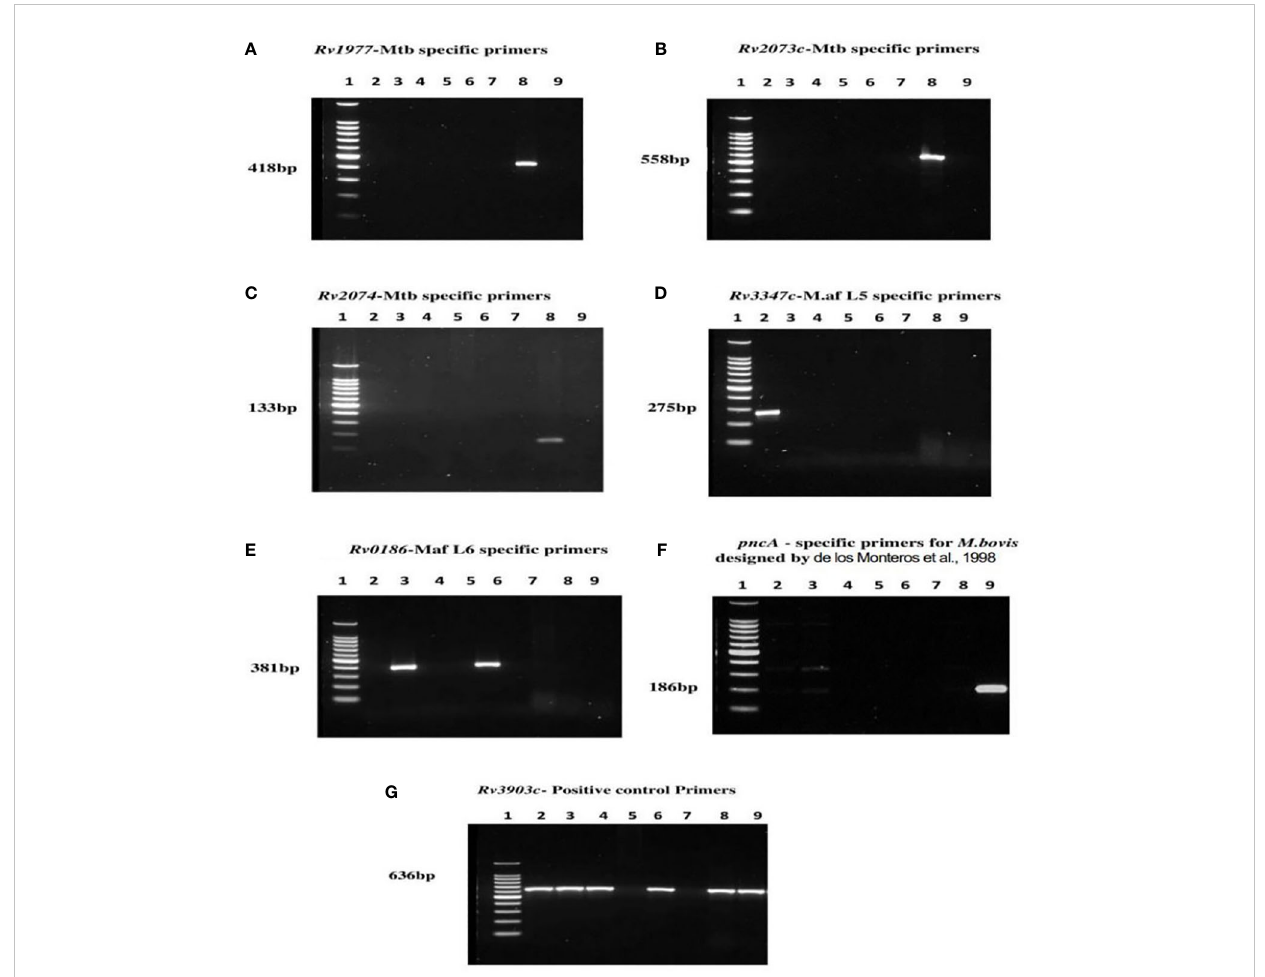
FIGURE 4 PCR results of MTBC speci fi c lineages after optimization of various product sizes; Lane 1= DNA ladder, 2= M. africanum L5, 3= M. africanum L6 (isolate a), 4=BCG, 5= E . coli , 6= M. africanum L6 (isolate b), 7= water, 8= M. tuberculosis and 9= M. bovis . Each of the primers was tested against genomic DNA of all MTBCs for speci fi city. DNA of E . coli and nuclease-free water were used as negative and non-template controls respectively. Optimum separation of PCR products was achieved with 2% agarose gel at 80V, 1hr:30mins. Primers designed from genes; (A) Rv1977 , (B) Rv2073c , and (C) Rv2074 amplifying at 418 bp, 558 bp and 133 bp respectively were speci fi c for Mtb. The M. africanum L5 and M. africanum L6 primers were set at 275 bp and 381bp respectively as shown in (D, E) . Primers developed from pncA gene by de los Monteros et al., 1998 were used for M.